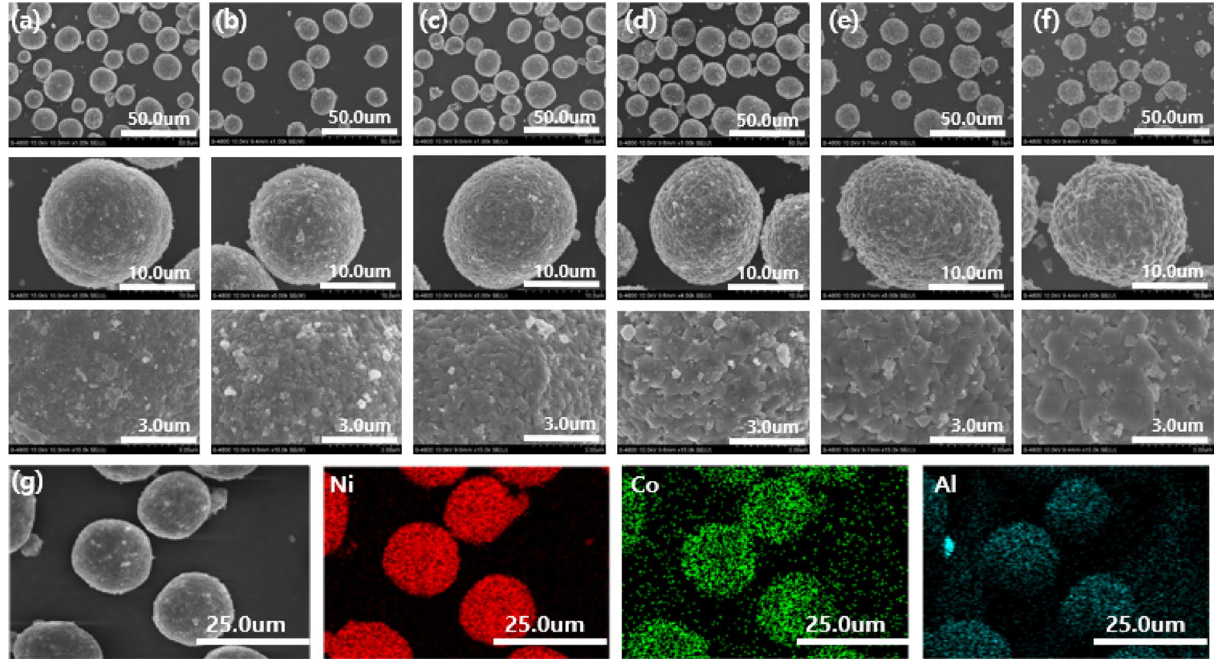
Figure 3. FE-SEM images of NCA sintered at ( a ) 660 °C, ( b ) 690 °C, ( c ) 720 °C, ( d ) 750 °C, ( e ) 780 °C and ( f ) 810 °C ( g ) EDS mapping of NCA sintered at 720 °C.